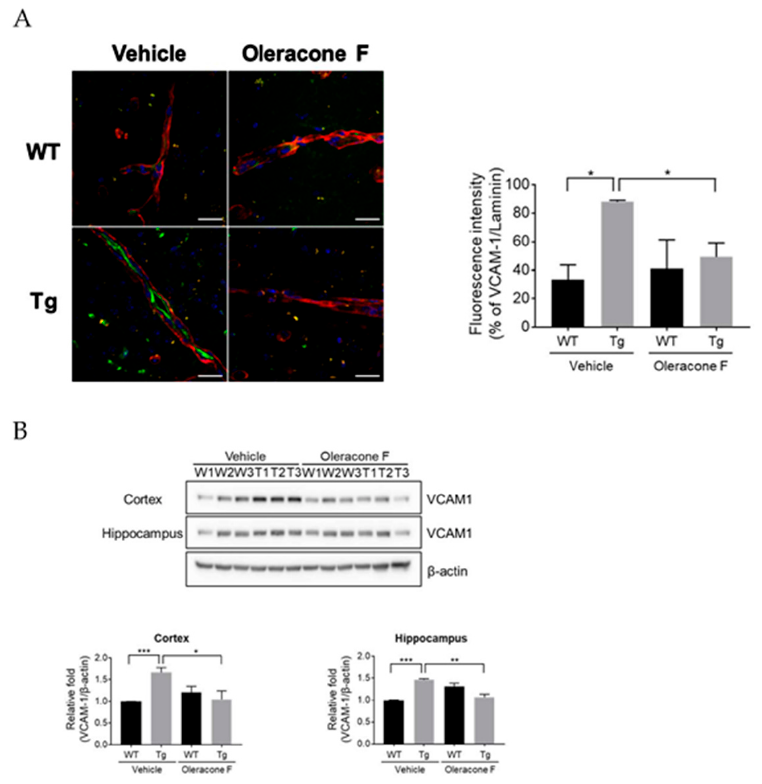
Figure 4. The expression of VCAM-1 is induced in AD transgenic mice, but this increase was blocked by oleracone F. WT and Tg mice were injected with saline or oleracone F (5 µ g/kg, i.p) for 4 weeks. ( A ) Sections from mouse brains were immunostained with antibodies against VCAM-1 (red) and laminin (green). Scale bar, 50 µ m. Quantifications of the VCAM-1 and laminin immunoreactivities were performed using densitometry (ImageJ software, 1.49 v). Bar graphs of VCAM-1 or laminin represent mean ± SEM (n = 4). ( B ) The VCAM-1 protein levels were determined by Western blot analysis using 30 µ g of protein extracts obtained from the mouse cortex and hippocampus. Quantifications of the bands were performed using densitometry (ImageJ software, 1.49 v). Results were normalized to β -actin. Data represented are mean ± SEM (n = 3). Statistical significances are denoted as * p < 0.05, ** p < 0.001, and *** p <